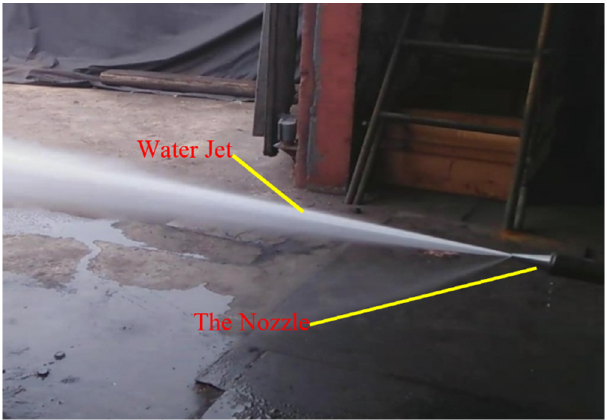
Figure 17. Performance of the water jet.